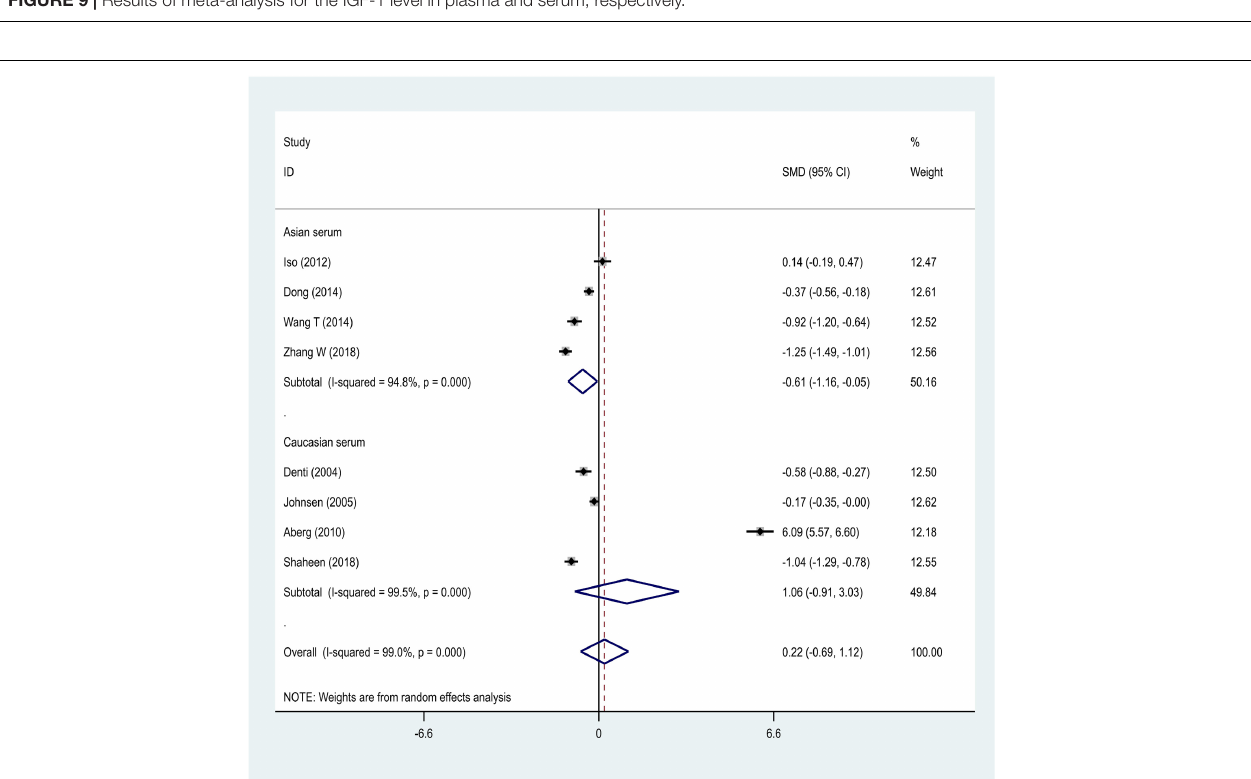
FIGURE 10 | Results of meta-analysis for the IGF-1 serum levels in Caucasian, Asian, IS, and control groups, respectively.